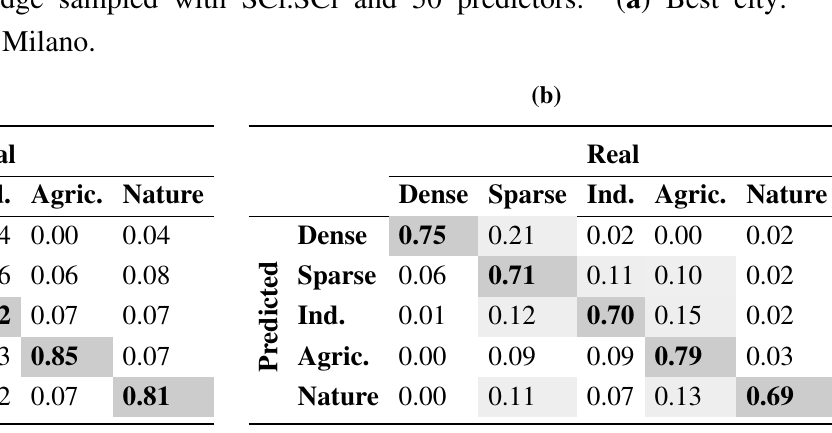
Table 4. Confusion matrix of München and Milano with the five classes (dense residential, sparse residential, industrial, agricultural, nature); result obtained with a cross-city model with background knowledge sampled with SCi.SCl and 50